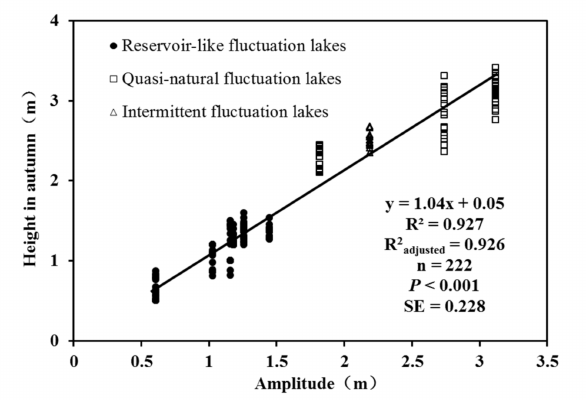
Figure 4. Relationships between plant height of Typha angustifolia in autumn and annual water level fluctuation (WLF) amplitude in all study lakes in which it was found. Autumn height represents the maximum at the end of the growing season (September or